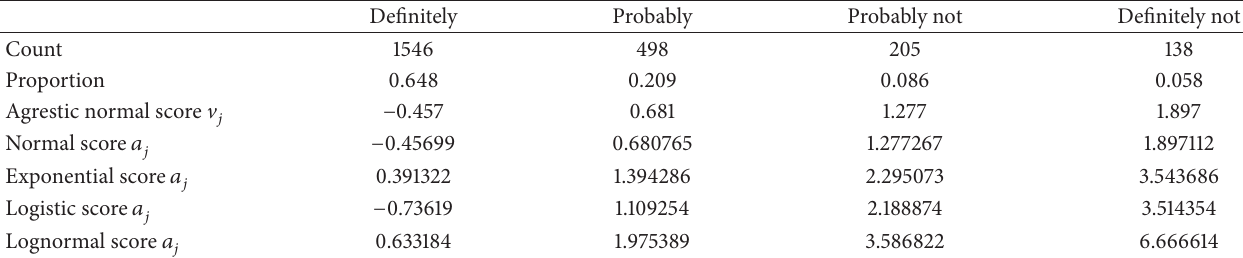
Table 4: The results of responses about belief in heaven with different formulas.